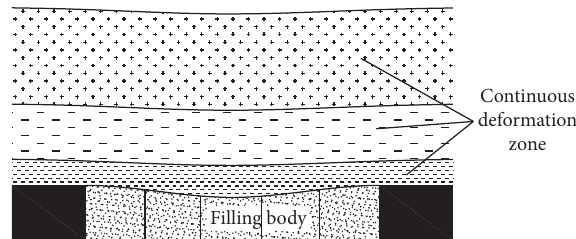
Figure 9: Schematic diagram of immediate roof bending defor- mation with roadway backfill.